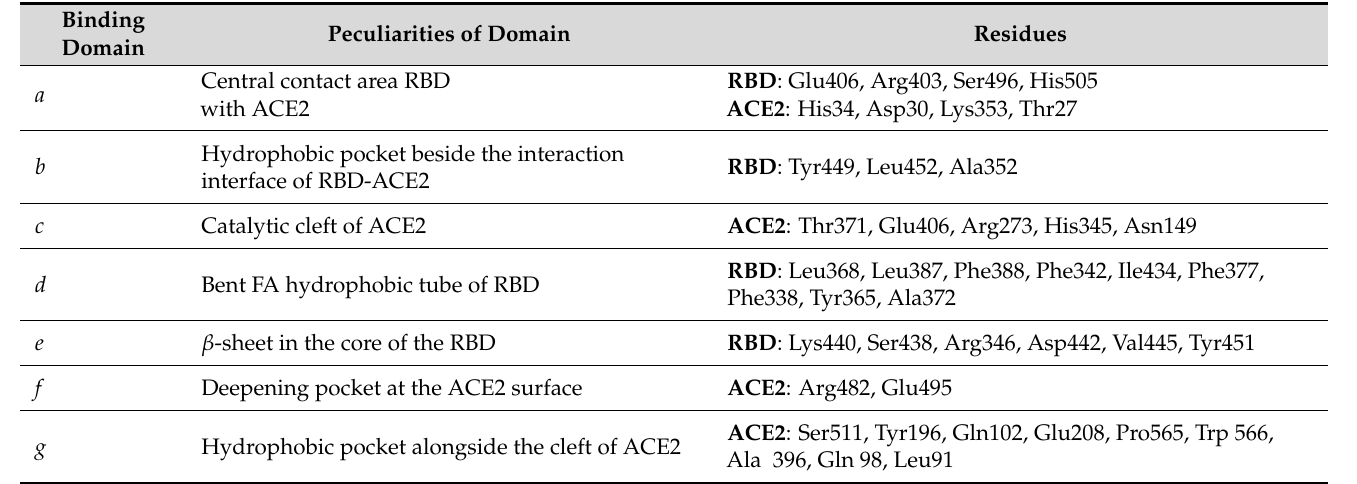
Table 2. A brief description of the binding domains a – g